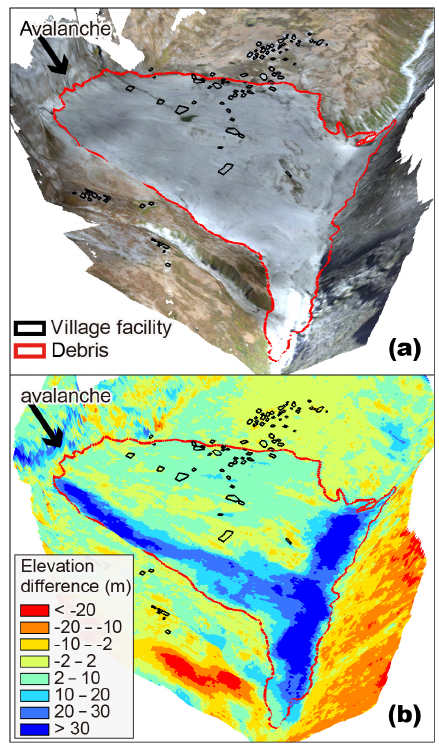
Figure 12. Three-dimensional views of (a) orthomosaic (23 Octo- ber 2015, same as Fig. 2a) and (b) elevation difference (7 May 2015 vs. ALOS DEM, same as Fig. 5a) over the Langtang village. Red and black polygons denote debris extent and village facility, which was manually delineated from ALOS PRISM image taken in De- cember